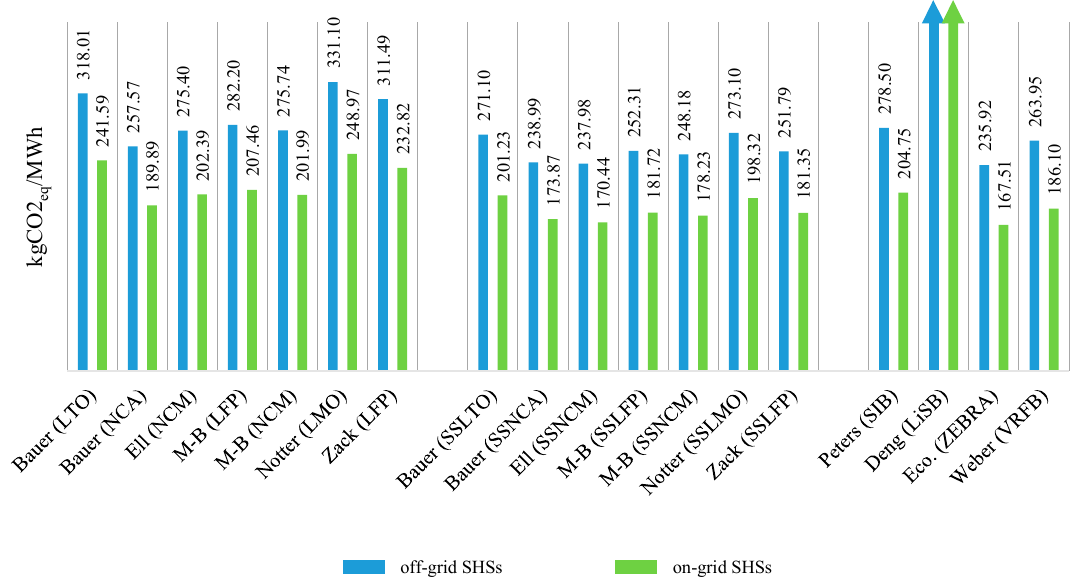
Figure 2. LCA impact values of SHSs in Italy for the climate change indicator.